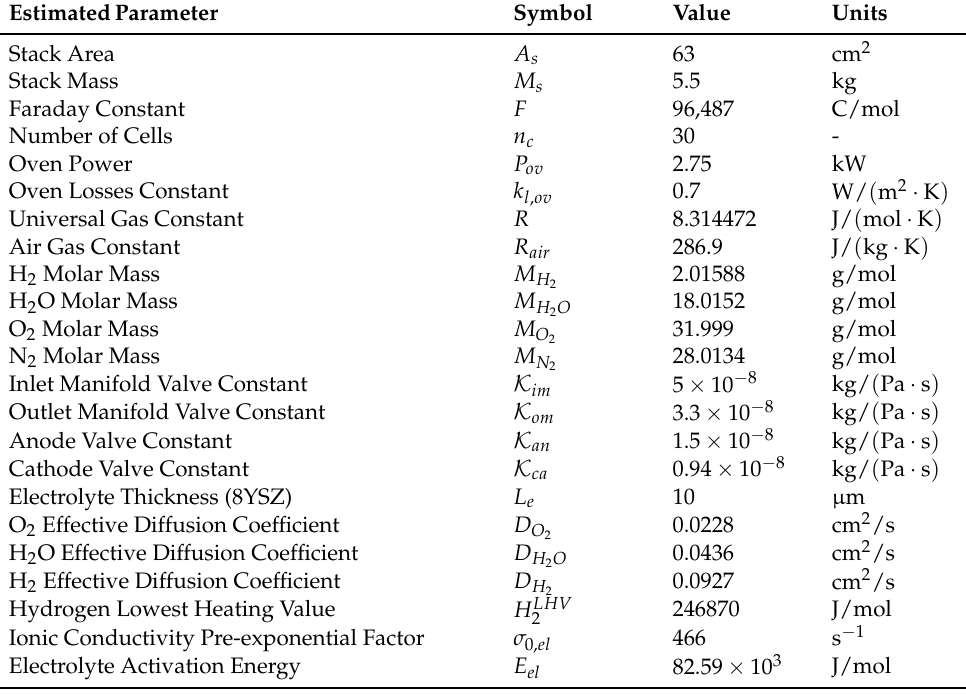
Table A1. Defined Parameters.